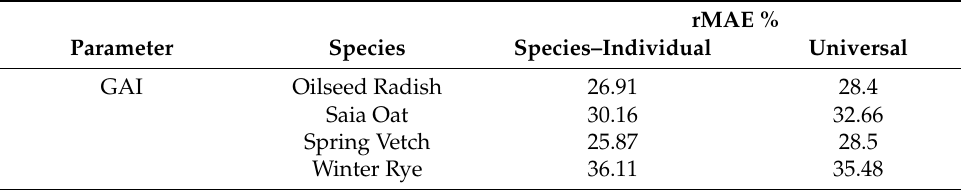
Figure 7. Species-individual models using SR red for estimation of ( A ) green area index (GAI), ( B ) dry matter (DM) (g m − 2 ), and ( C ) N uptake (g m − 2 ). Model performance was assessed with R 2 and the relative mean absolute error (rMAE) (%). Calibration formula is noted for each species and each canopy parameter. Table 5. Comparison of the two model approaches’ prediction performance (species–individual vs. universal models) for green area index (GAI), dry matter (DM), and N uptake (N) by relative mean absolute error (rMAE) (%) for each separate cover crop (oilseed radish, saia oat, spring vetch, winter